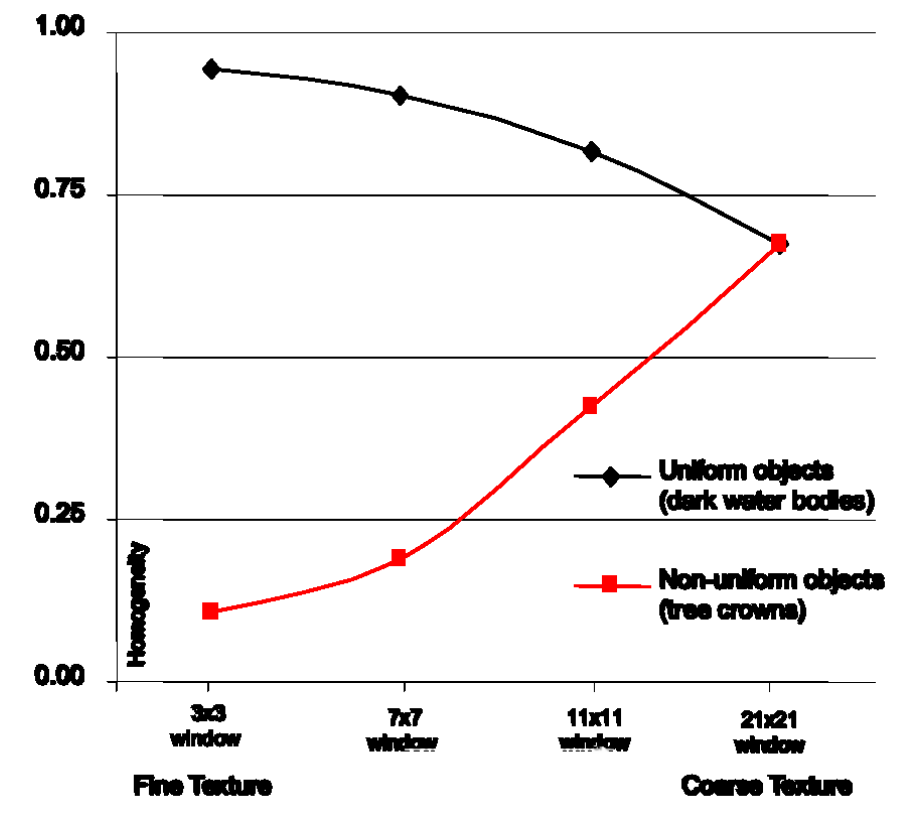
Figure 6. Texture results for varying window sized of image